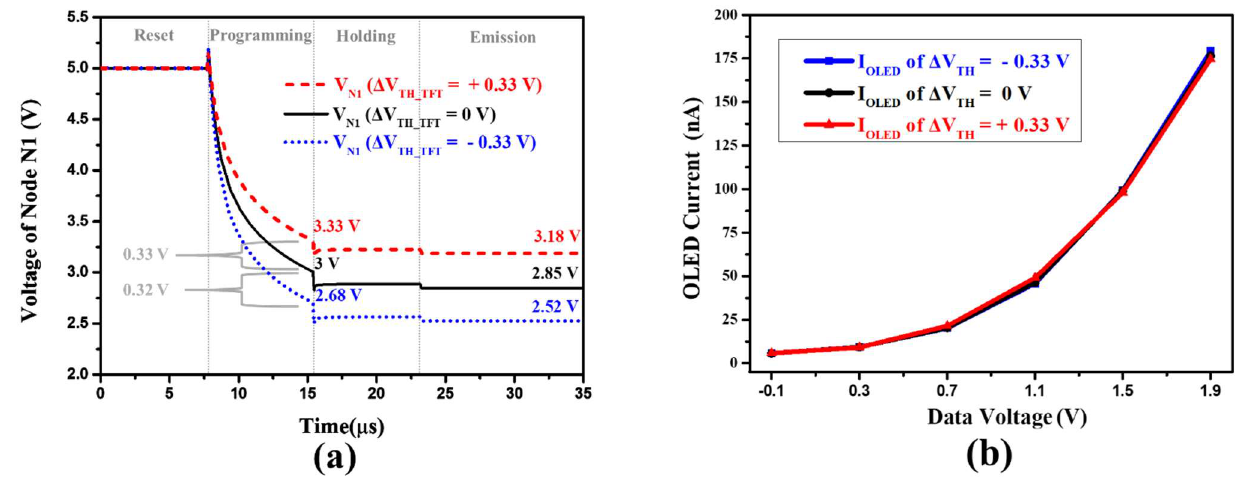
Figure 5. The ( a ) simulated transient waveforms of node N1 voltage operating at 120 Hz when V TH